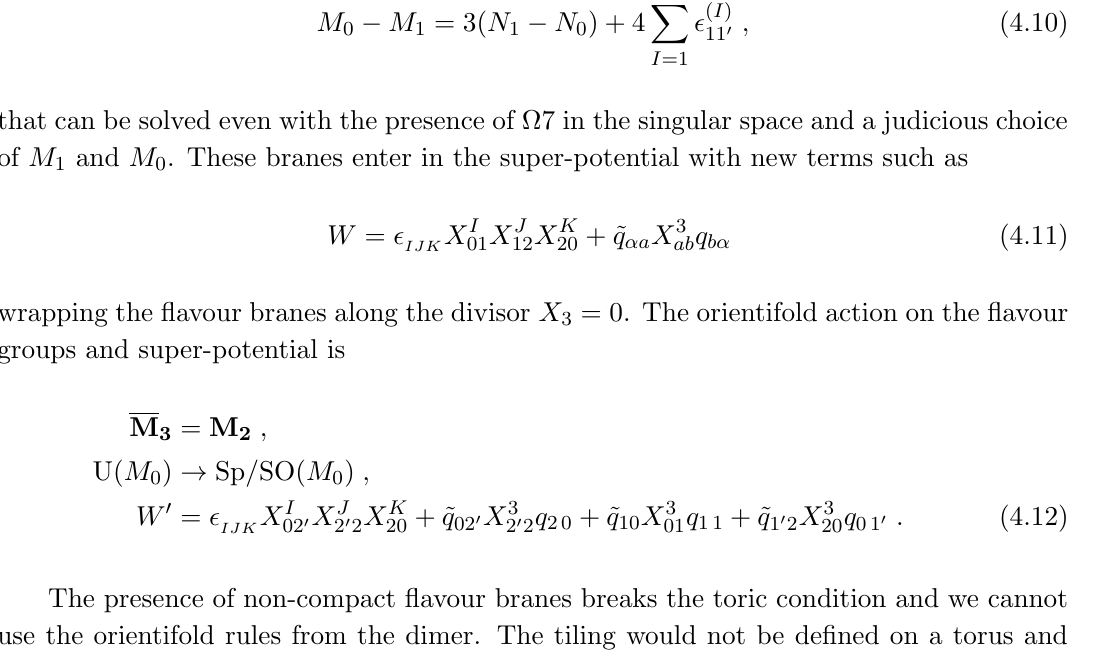
from which (cid:13)